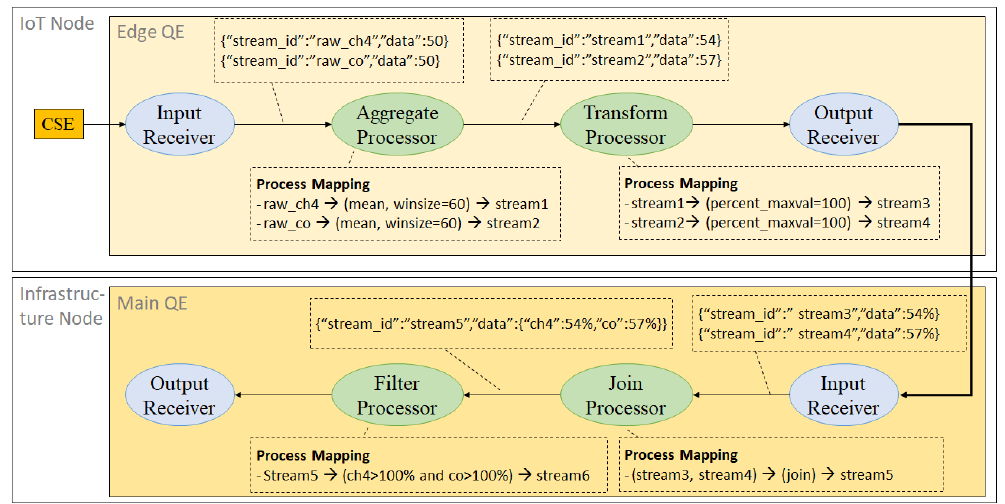
Figure 12. An illustration of data processing inside stream query